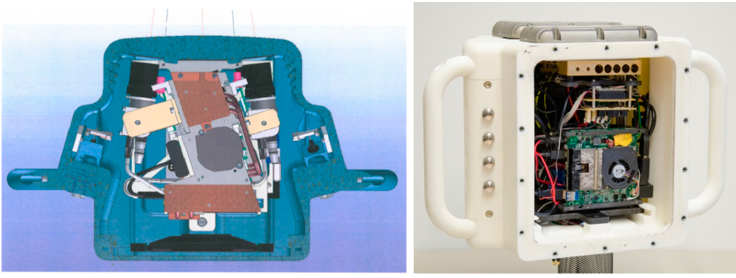
Figure 7. Housing views: construction draw, view from above ( left ), sensor inside housing without back-panel ( right ).